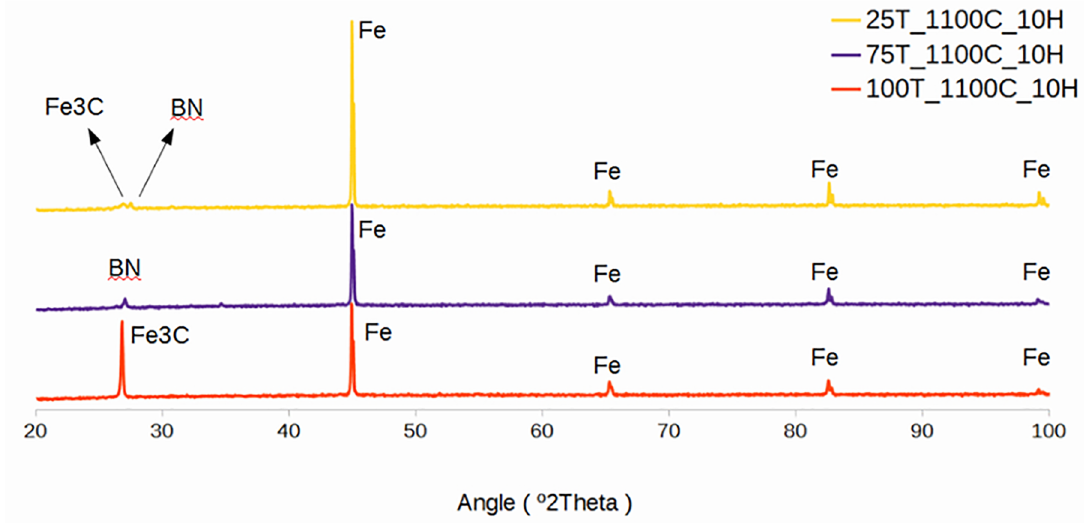
Figure 7. X-ray diffraction patterns obtained at the surface of the AISI 1020 steel thermochemically treated with mixtures Turbonit ® +Ekabor ® and Turbonit ® during 10 h at 1100º C.